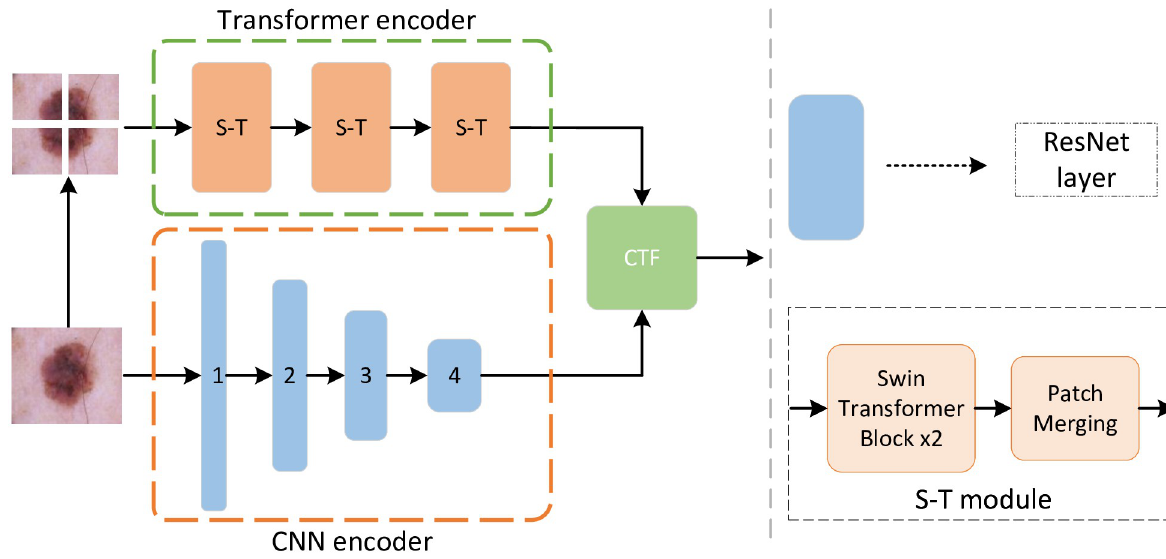
Fig 2. The architecture of feature fusion